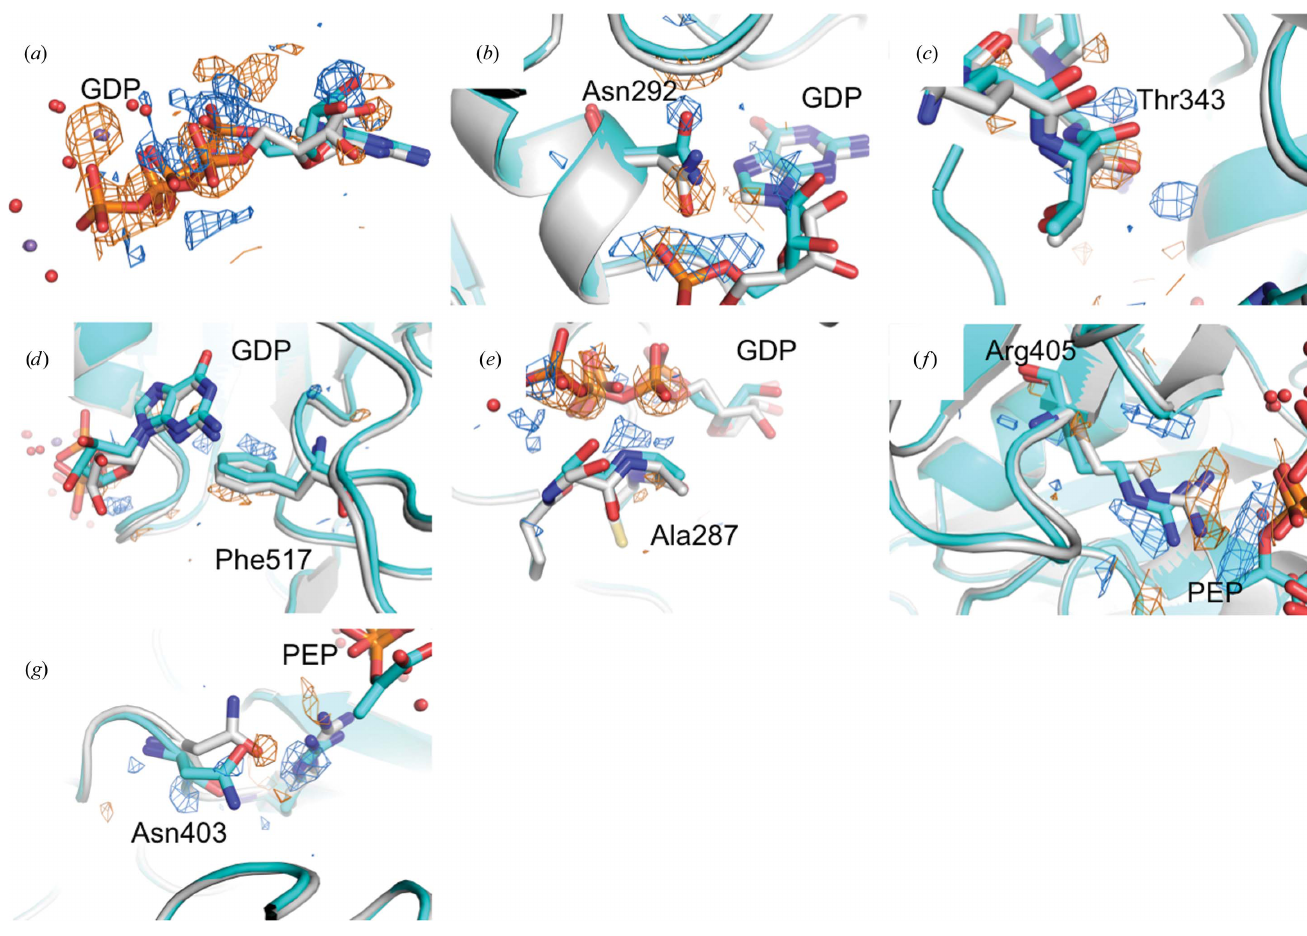
Figure 3 Side-chain and GTP-binding pocket motions associated with GDP relaxation 40 ms post-reaction. F o (cid:4) F o maps are contoured at (cid:6) 3.5 r.m.s.d. (positive, blue; negative, orange). ( a ) GTP (gray, umixed) (cid:4) GDP (cyan, 40 ms) relaxation. ( b ) Asn292 motion. ( c ) Thr343 loop motion. ( d ) Phe517 side-chain breathing. ( e ) Ala287 motion into phosphate-binding cleft. ( f ) Arg405 motion away from the active site. ( g ) Asn403 twist away from the active